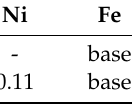
Table 1. Chemical composition of AISI 52100 and AISI D3 steels (wt.%). Steel